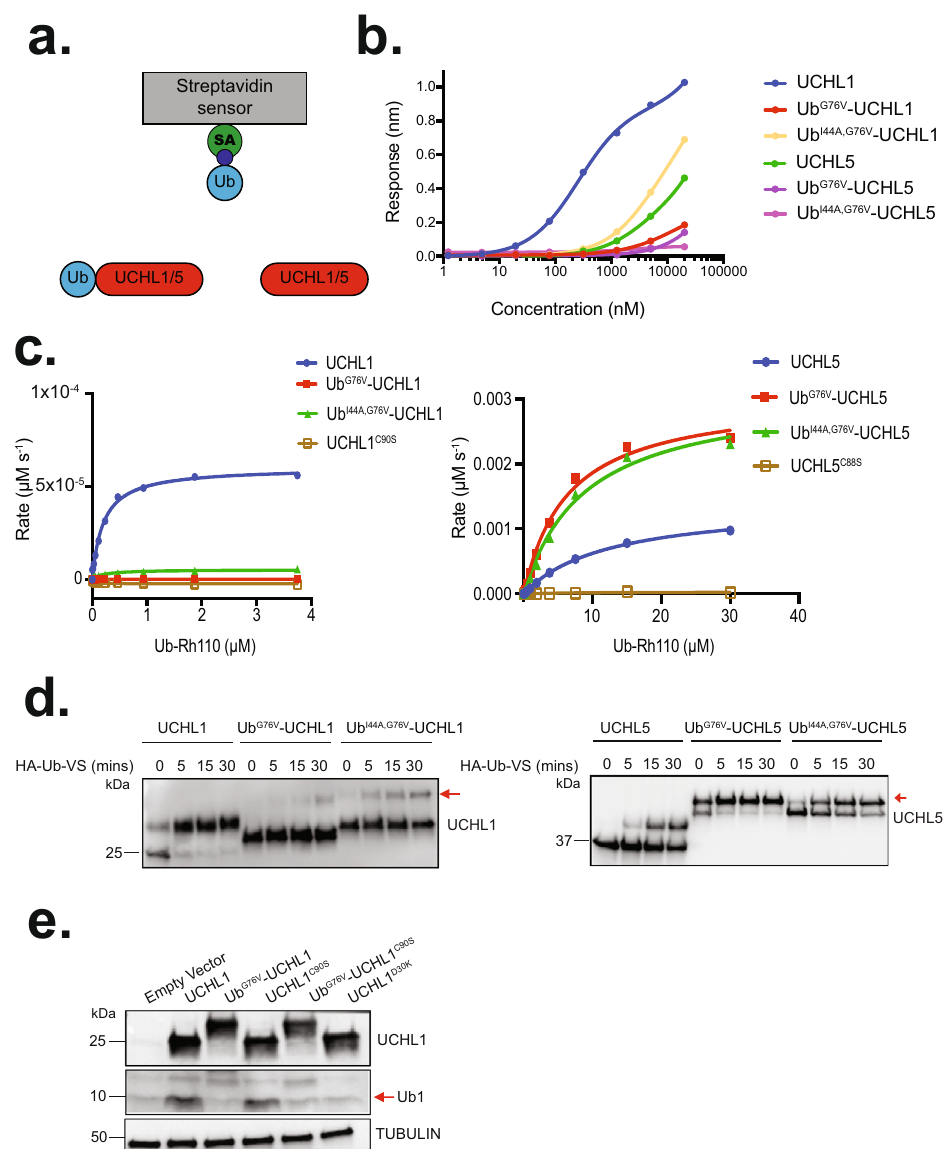
Fig. 8 N-terminal monoubiquitination of UCHL1 and UCHL5 differentially regulates their DUB activities. a Graphical representation of the Bio-Layer interferometry (BLI) experiments. UCHL1 and UCHL5 interactions were performed using immobilized biotin-Ub on a streptavidin biosensor, measuring the association of free UCHL1 or UCHL5 and Ub-UCHL1 or UCHL5 with surface-bound Ub. Streptavidin, Ub, and UCHL1/5 are shown in green, blue, and red, respectively. b Combined steady-state binding curves for UCHL1, Ub G76V -UCHL1, Ub I44A,G76V -UCHL1, UCHL5, Ub G76V -UCHL5, and Ub I44A,G76V -UCHL5 are shown in blue, red, yellow, green, purple, and pink, respectively. Response values in nanometers (nm) are plotted for each concentration of the analyte. Each assay was performed in triplicate. c Activity assays were performed with Ub-Rho110 and UCHL1 constructs (left) and UCHL5 constructs (right). For UCHL1 and UCHL5, we included the wild-type protein, catalytically dead mutant (UCHL1 C90S or UCHL5 C88S ), or the N-terminally ubiquitinated mimetics (Ub G76V and Ub G76V,I44A ). UCHL1, Ub G76V -UCHL1, Ub I44A,G76V -UCHL1, and UCHL1 C90S are shown in blue, red, green, and beige, respectively. UCHL5, Ub G76V -UCHL5, Ub I44A,G76V -UCHL5, and UCHL5 C90S are shown in blue, red, green, and beige, respectively. Data are reported as best- fi t values with SEs from nonlinear regression fi t. Results are representative of two independent experiments. d UCHL1 and its N-terminally ubiquitinated mimetic, Ub G76V - UCHL1 and Ub I44A,G76V -UCHL1 (left) and UCHL5 and its N-terminally ubiquitinated mimetic, Ub G76V -UCHL5 and Ub I44A,G76V -UCHL5 (right) were allowed to react with the suicide probe ubiquitin-vinyl sulfone (Ub-VS) for the indicated time points. The red arrow indicates the band associated with the N-terminally ubiquitinated mimetic reacting with HA-Ub-VS. Results are representative of three independent experiments. e Western blots of COS-7 cells transfected with wild-type UCHL1, Ub G76V -UCHL1, UCHL1 C90S (catalytically inactive mutant), Ub G76V -UCHL1 C90S , and UCHL1 D30K (non-Ub-binding mutant) at 24 h post-Dox treatment. MonoUb is indicated by the arrow. Results are representative of two independent experiments. Source data are provided as a Source Data fi